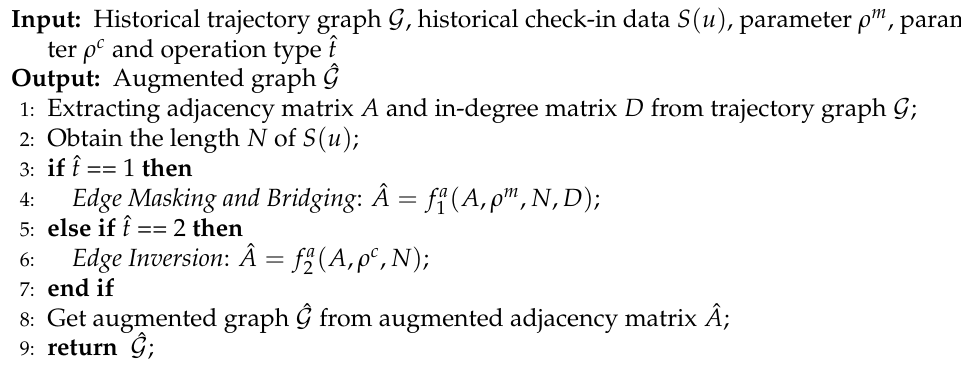
Algorithm 1 Graph data augmentation operation for user u